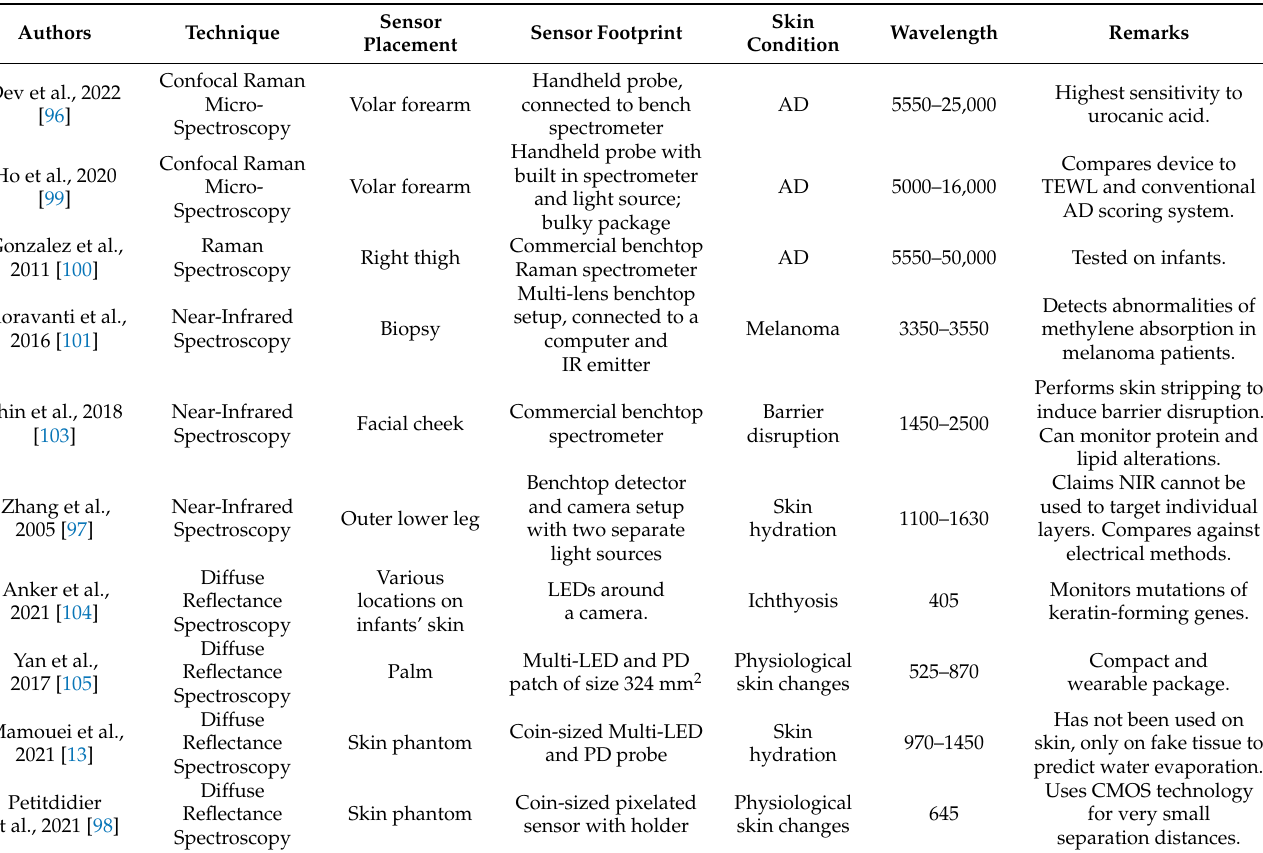
Table 4. Summary of literature findings of optical spectroscopy for the purposes of AD and skin condition